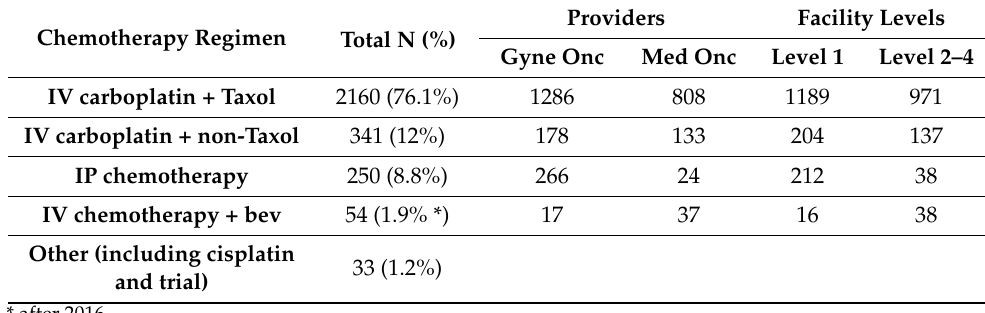
Table A7. Chemotherapy regimen breakdown.